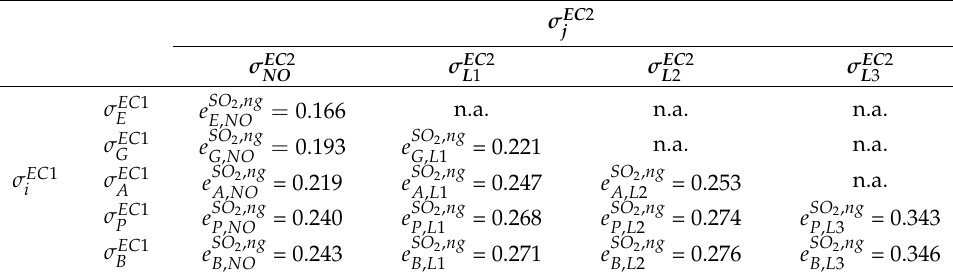
Table 5. Computational results of the virtual SO 2 emission in kg within one